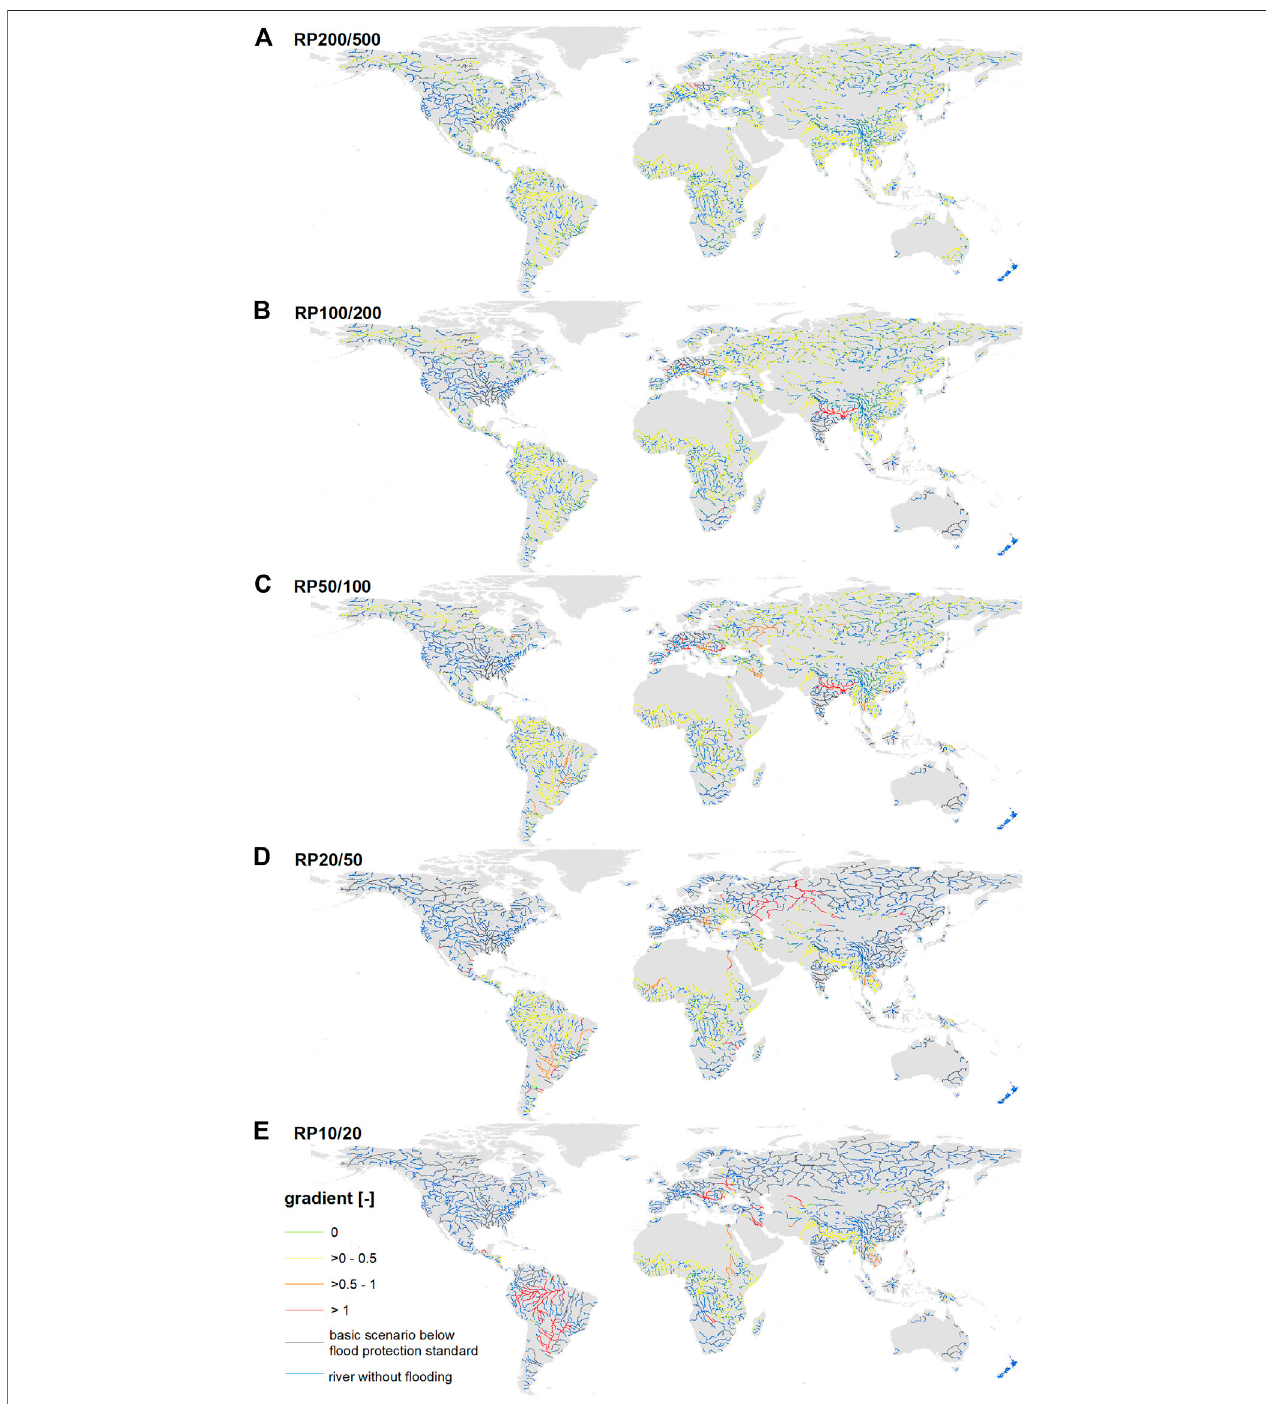
FIGURE 7 | Sensitivity of population exposure in the world ’ s main river fl oodplains to changes in fl ood magnitude. Normalized gradient between the increase in exposed population and the increase in frequency from the downward counterfactual analysis of a design fl ood of (A) 1-in-200 years, (B) 1-in-100 years, (C) 1-in- 50 years, (D) 1-in-20 years, and (E) 1-in-10 years.